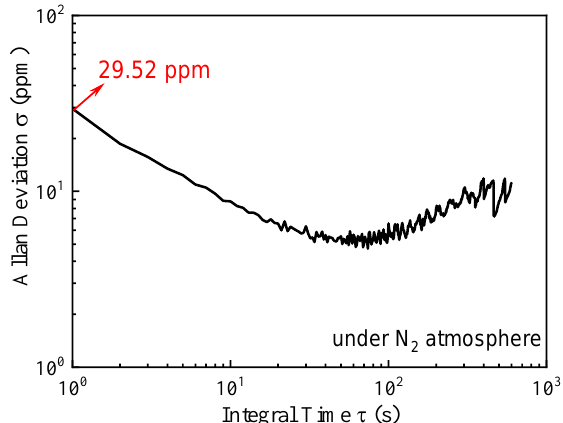
Figure 9. Standard gas tests of the detection system while the methane concentration is 600 ppm.